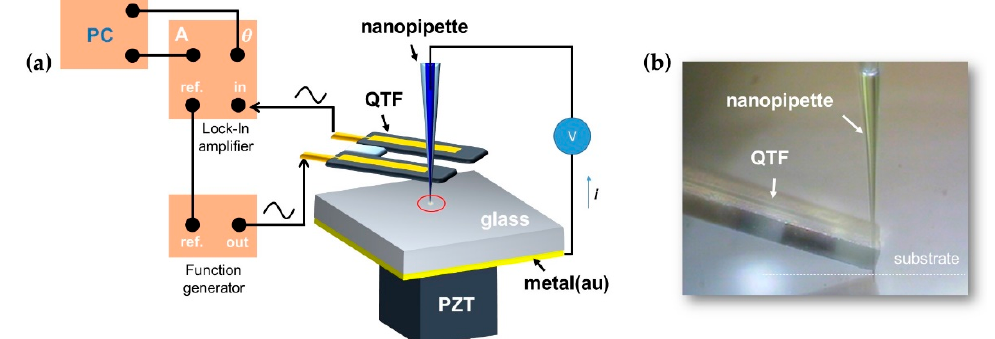
Figure 3. Nanopipette/quartz tuning fork–atomic force microscope (QTF–AFM): ( a ) Schematic of experiment. The nanopipette is attached laterally on the prong of the QTF, and it approaches the surface with the guidance of the QTF–AFM, while the mechanical interactions are recorded by the detection of the amplitude and phase signals of the QTF sensor with a lock-in amplifier and function generator; ( b ) side view of the liquid-filled nanopipette attached on the prong of the QTF sensor.